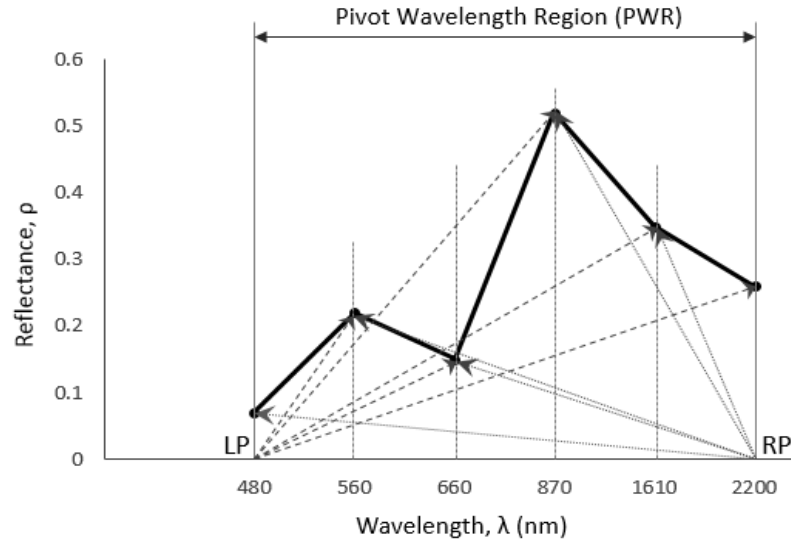
Figure 3. Schematic diagram of MDI applied on a sample spectral reflectance curve of a green vegetation. Note that the number of points between LP and RP pivots can vary depending on the number of bands analyzed or the width of the pivot wavelength region.